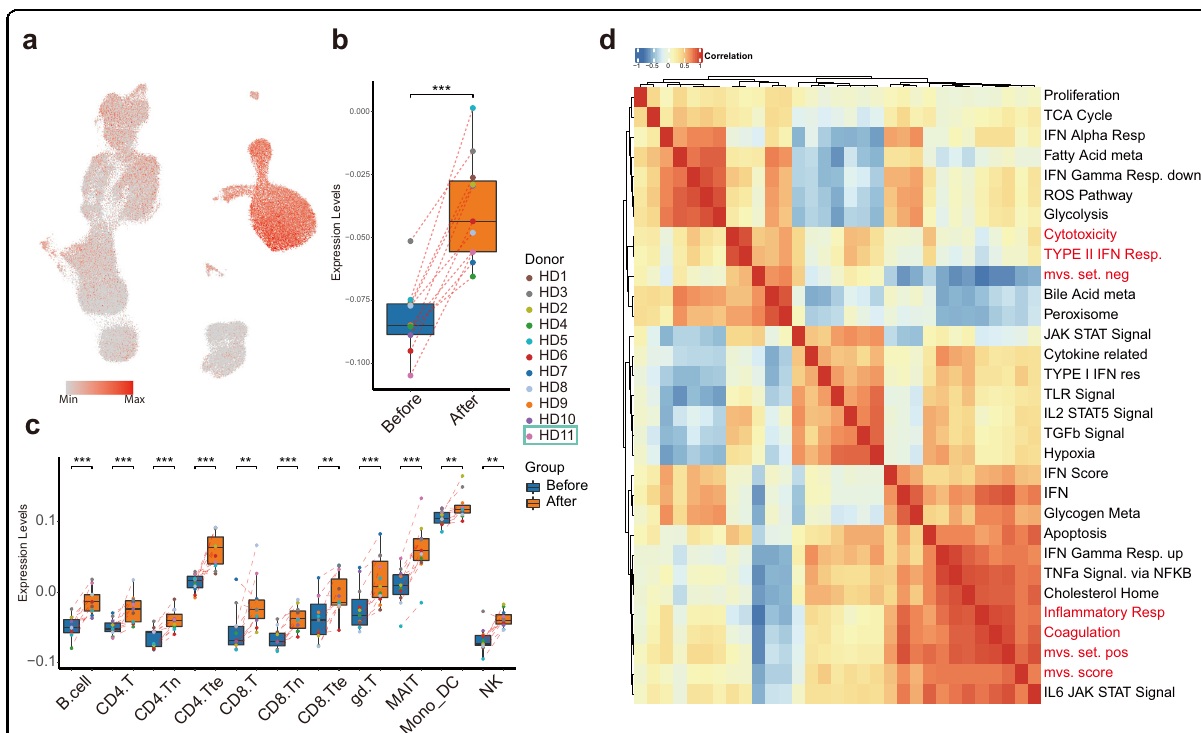
Fig. 6 Monocytes displayed high MVS scores and MVS score-correlated pathways. a UMAP visualization colored by MVS scores. b MVS scores in pseudo-bulk samples combining all cell types showed upregulation after vaccination. c Box plots depicting the score distribution amongst 11 major immune cell types before and after vaccination. d Heatmap of correlation between MVS scores and enriched pathways of differentially expressed genes before and after